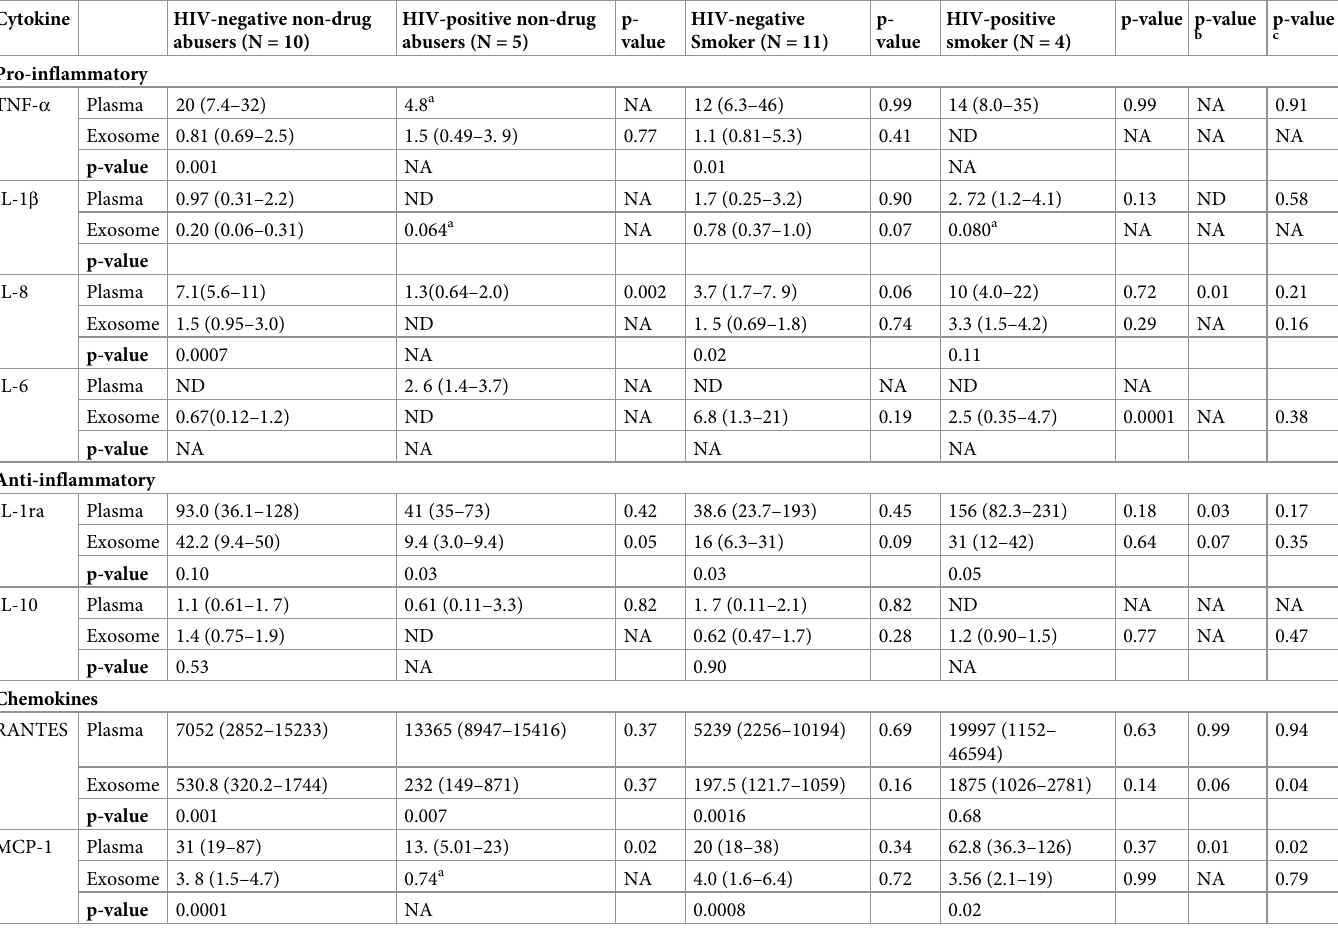
Table 2. Comparison of cytokine and /chemokine levels between HIV-negative subjects, HIV-positive non-drug abusers, HIV-negative smokers, and HIV-positive non-smokers.